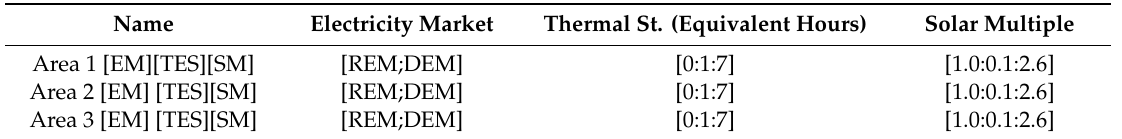
Table 5. Defined cases studies for optimal plant investment. Note: REM, Regulated Electricity Market; DEM, Deregulated Electricity